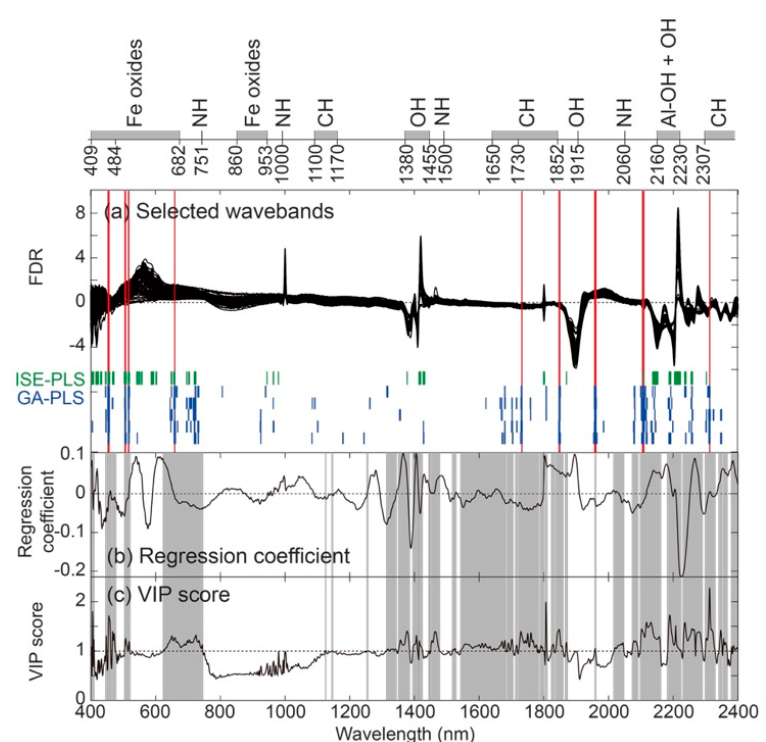
Figure 5. ( a ) Selected wavebands in ISE-PLS analysis (green bars) and GA-PLS (blue bars in each run) using the FDR data set ( n = 103) to estimate oxalate-extractable P contents of upland and lowland soils, with commonly selected wavebands from five GA-PLS runs (red bars), ( b ) regression coefficients in the FS-PLS model, and ( c ) VIP score (>1, grey bars). Specific absorption wavebands for the different bonds present in soil are specified on the top x-axis (modified by [58]).